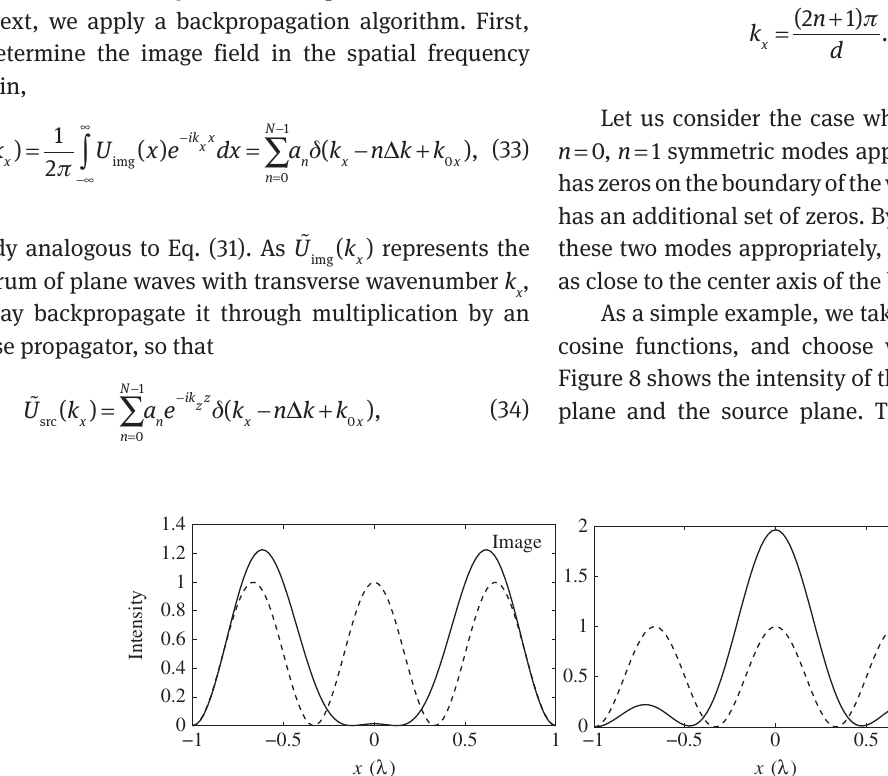
Figure 8: The superoscillatory function designed by the Wong and Eleftheriades method, showing both the intensity in the image plane and the source plane. The waveguide is taken to have d = 2 λ , and z = 5 λ . The dashed line indicates the oscillation of the highest propagating mode of the